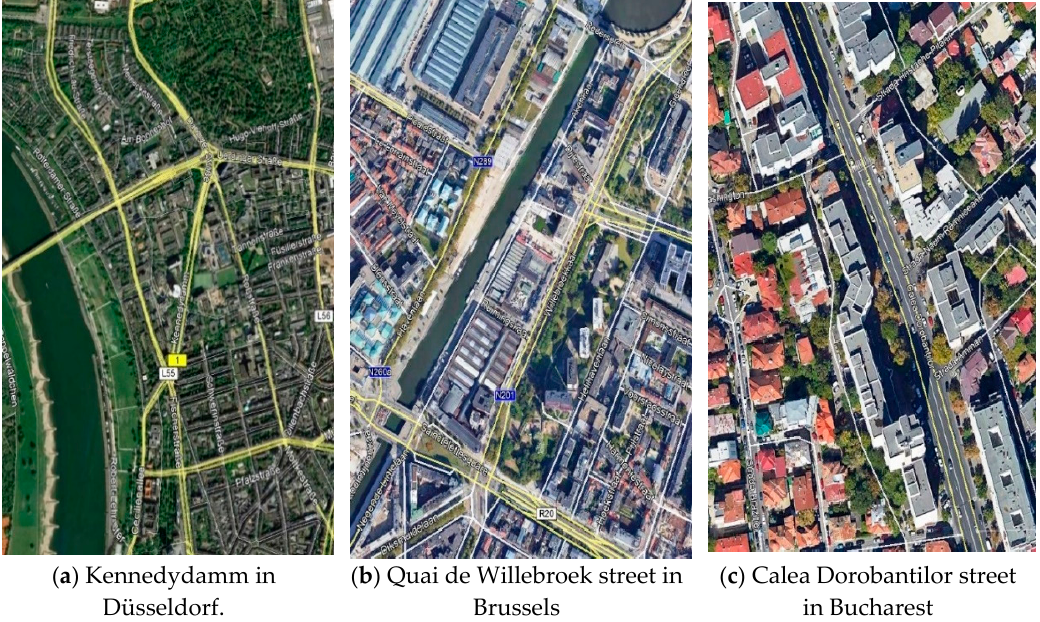
Figure 2. Streets with comparable urban traffic in the EU selected for observation. Source: Google Earth .